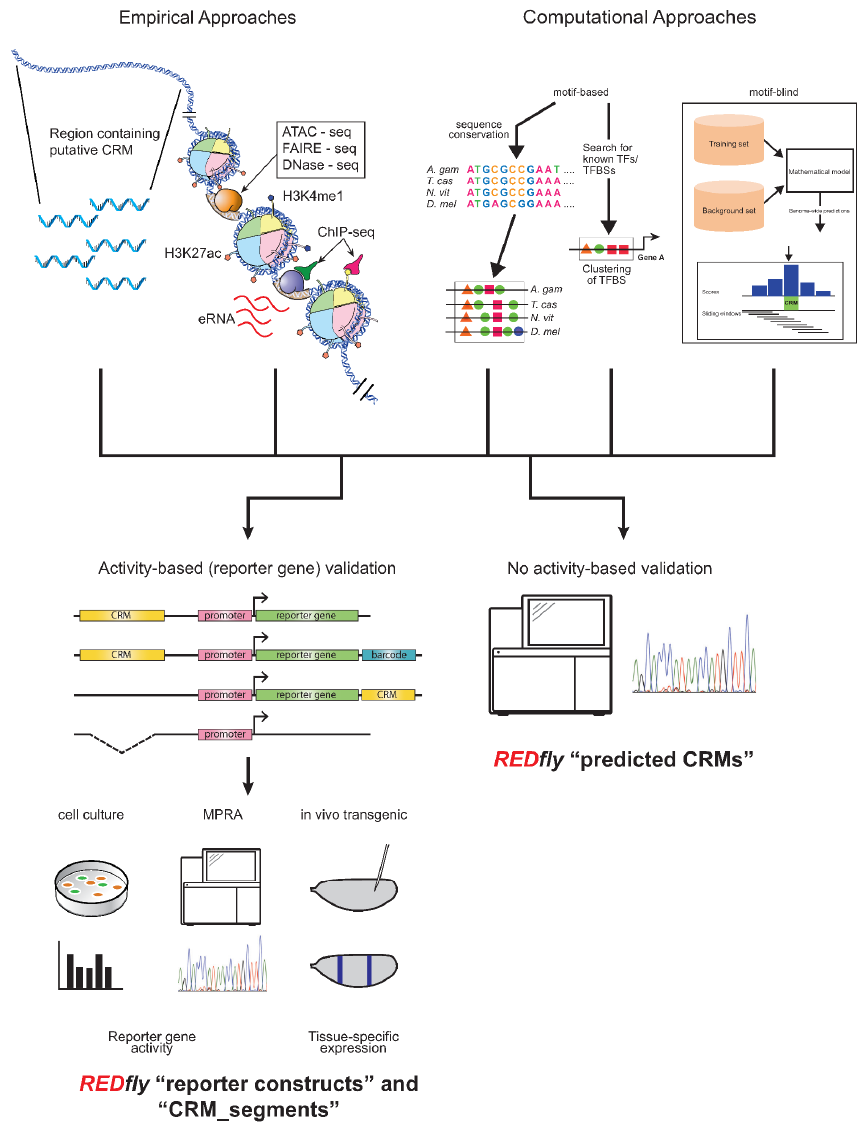
Figure 1. Activity-based and non-activity-based methods for defining regulatory sequences. Top: A wide variety of methods exist for identifying regulatory sequences based on both empirical ( left ) and computational ( right ) approaches. Empirical approaches include unbiased testing of non- coding DNA regions as well as selection of sequences based on chromatin accessibility, histone post-translational modification, transcription factor binding, production of enhancer RNAs, and others. Computational approaches may include assessment of sequence conservation, presence of transcription factor binding motifs, or various machine-learning methods. Bottom: Results from these regulatory element discovery methods can be obtained with ( left ) or without ( right ) the use of activity-based criteria. Activity-based criteria typically involve some sort of reporter-gene assay, which might be performed in cultured cells, using next-generation sequencing in a “massively parallel reporter assay” (MPRA), or in transgenic animals; recently, testing via genomic deletion via CRISPR/Cas9 has also been gaining popularity. REDfly classifies regulatory sequences derived from these methods as reporter constructs (RCs) and CRM_segments , while any methods that identify regulatory sequences without recourse to activity-based criteria are referred to as predicted CRMs (pCRMs) . These somewhat historical definitions should not be construed to imply that one or the other type of data is more accurate or